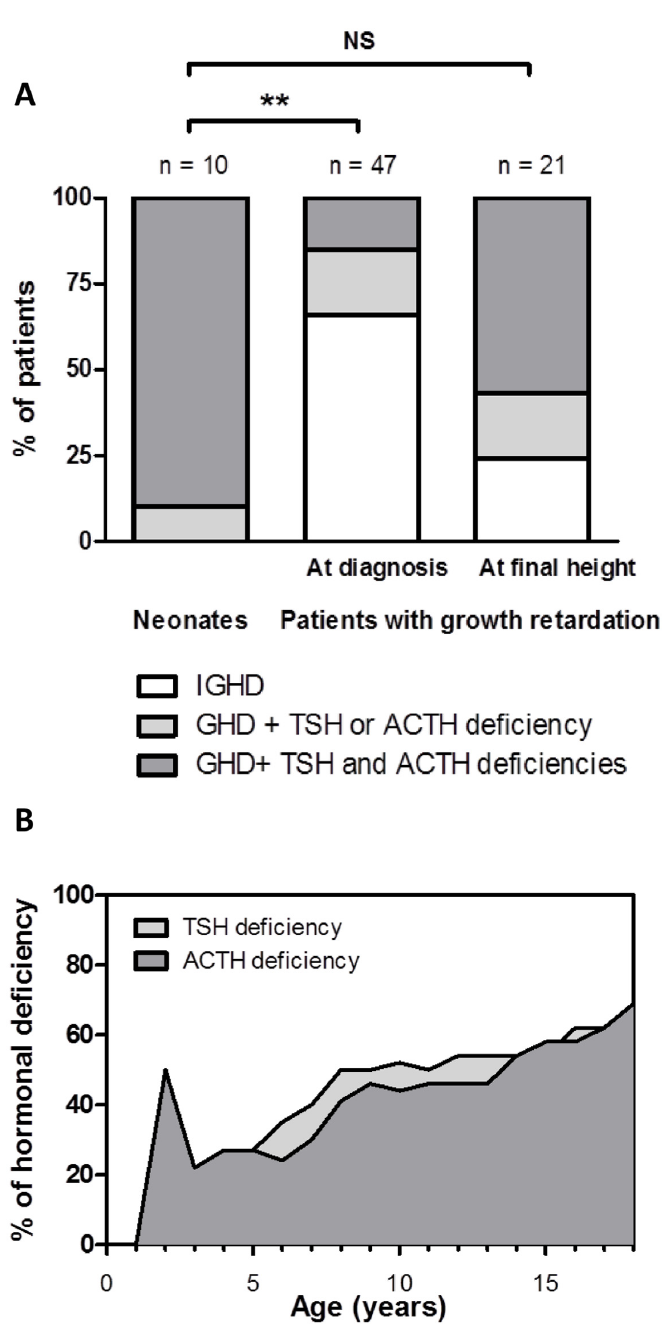
Fig 1. Evolution of the hormonal impairment according to the initial presentation. (A) Frequency of GH, ACTH and/or TSH deficiencies in neonates (n = 10) and patients with growth retardation, at baseline (n = 47) and at final height (n = 21). Significant statistical difference in the number of cases of combined pituitary hormone deficiency between groups of neonates and patients with growth retardation: ** P < 0.001 (chi square test). The gonadotropic axis was evaluated in neonates (during “ mini-puberty ” ) and in patients of postpubertal age. LH/FSH deficiency was found in 9 of 10 neonates (90%) and 12 of 21 patients with growth retardation at final height (57%); this was not statistically different (P = 0.1522). (B) Evolution of ACTH, and TSH deficiencies throughout childhood in patients with growth retardation who reached their final height (n = 21). All patients had GHD at